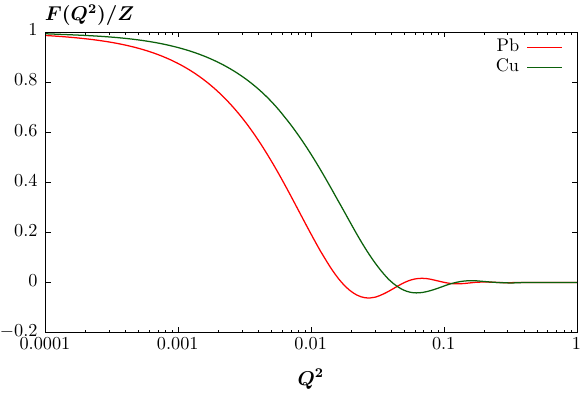
Fig. 2 Normalized charge form factor due to lead and copper ions